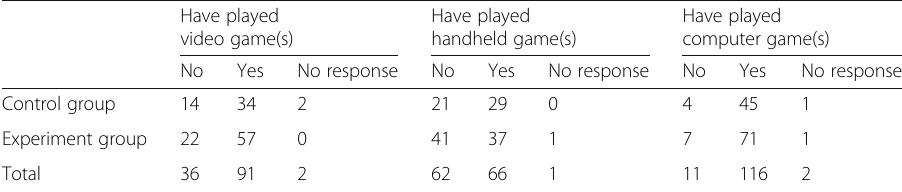
Table 5 Descriptive statistics of students ’ game